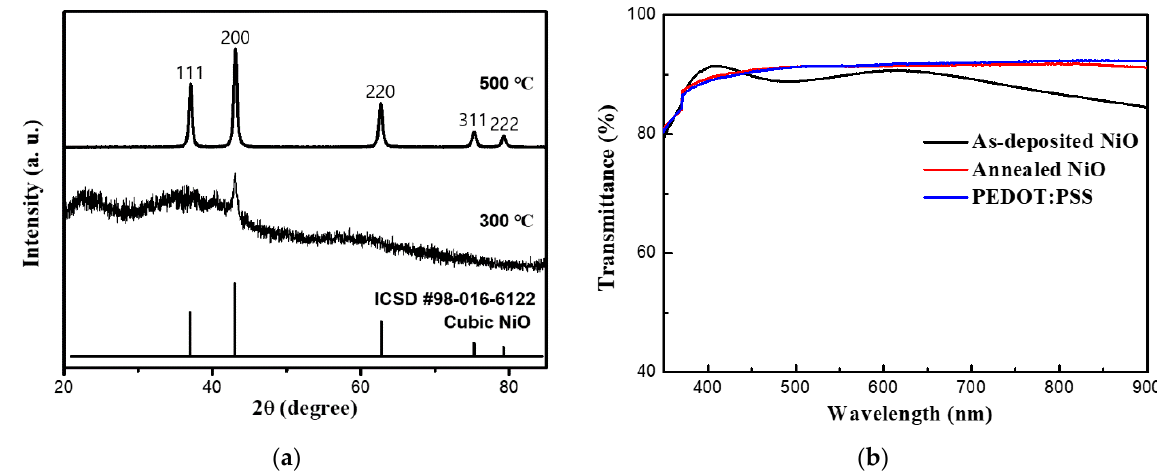
Figure 2. ( a ) XRD patterns of annealed NiO films and ( b ) optical transmittance spectra of PEDOT:PSS, as-deposited NiO, and annealed NiO films.